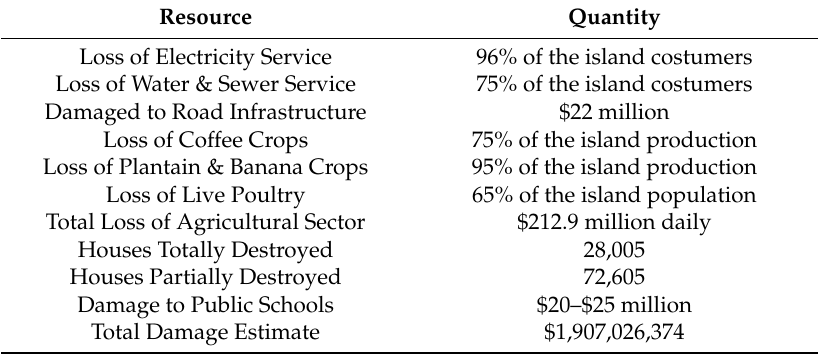
Table 2. Damages and losses produced by Hurricane Georges at Puerto Rico [16].